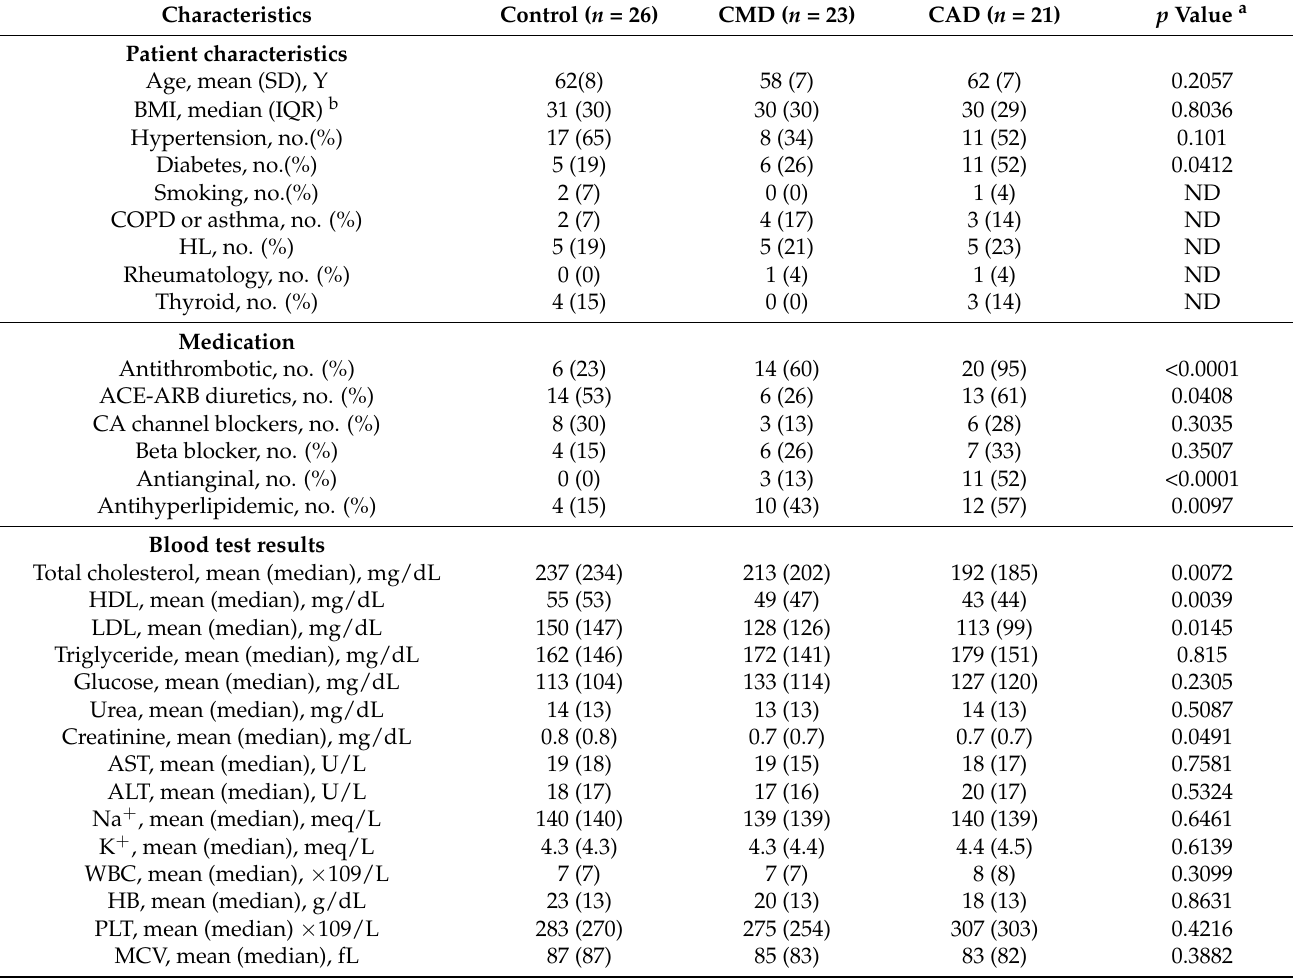
Table 1. Patient characteristics. CMD = coronary microvascular disease, CAD = coronary artery disease, BMI = body mass index, COPD = chronic obstructive pulmonary disease, ACE-ARB diuretics = angiotensin-converting enzyme inhibitor, and angiotensin receptor blocker diuretics, CA = calcium channel blockers, HDL = high-density lipoprotein, LDL = low-density lipoprotein, AST = aspartate aminotransferase, ALT = alanine aminotransferase, Na + = sodium, K + = potassium, WBC = white blood cell, HB = hemoglobin, PLT = platelet, MCV = mean corpuscular volume.